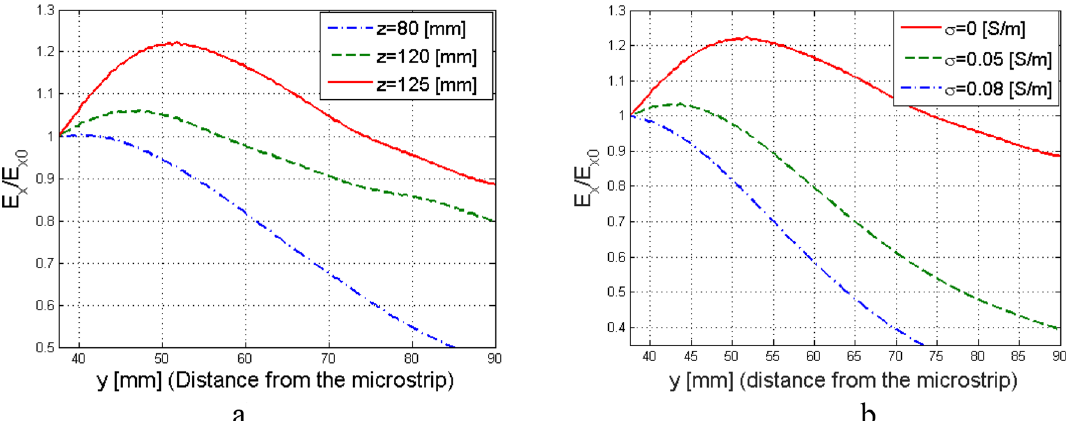
Figure 5. ( a ) Amplitude of the electric field E ( y ) produced by an LWA in a vacuum and sampled at a point p 0 = p ( 0, y j , z k ) normalised to the value of the electric-field amplitude calculated at p if = p